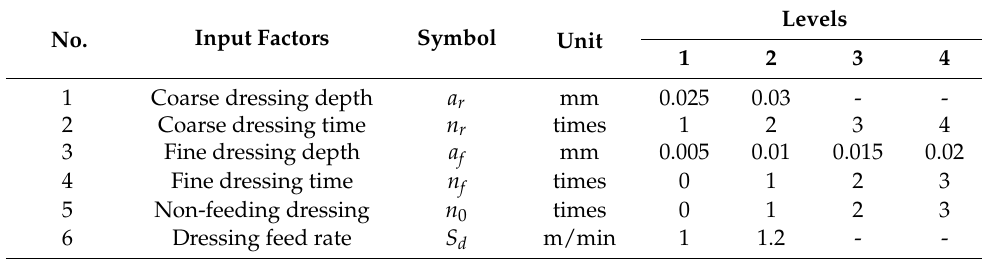
Table 1. Input parameters of the dressing